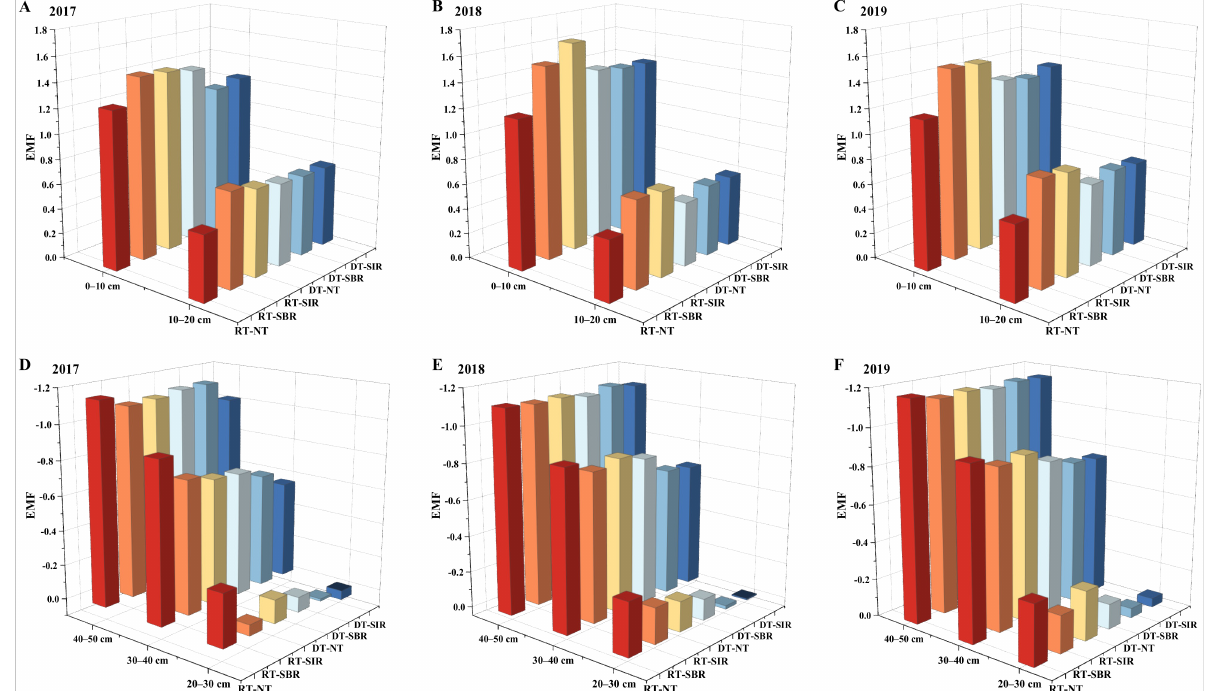
Figure 5. Soil ecosystem multifunctionality indexes in the 0–20 cm (( A ): 2017, ( B ): 2018, and ( C ): 2019) and in the 20–50 cm (( D ): 2017, ( E ): 2018, and ( F ): 2019) during 2017–2019.